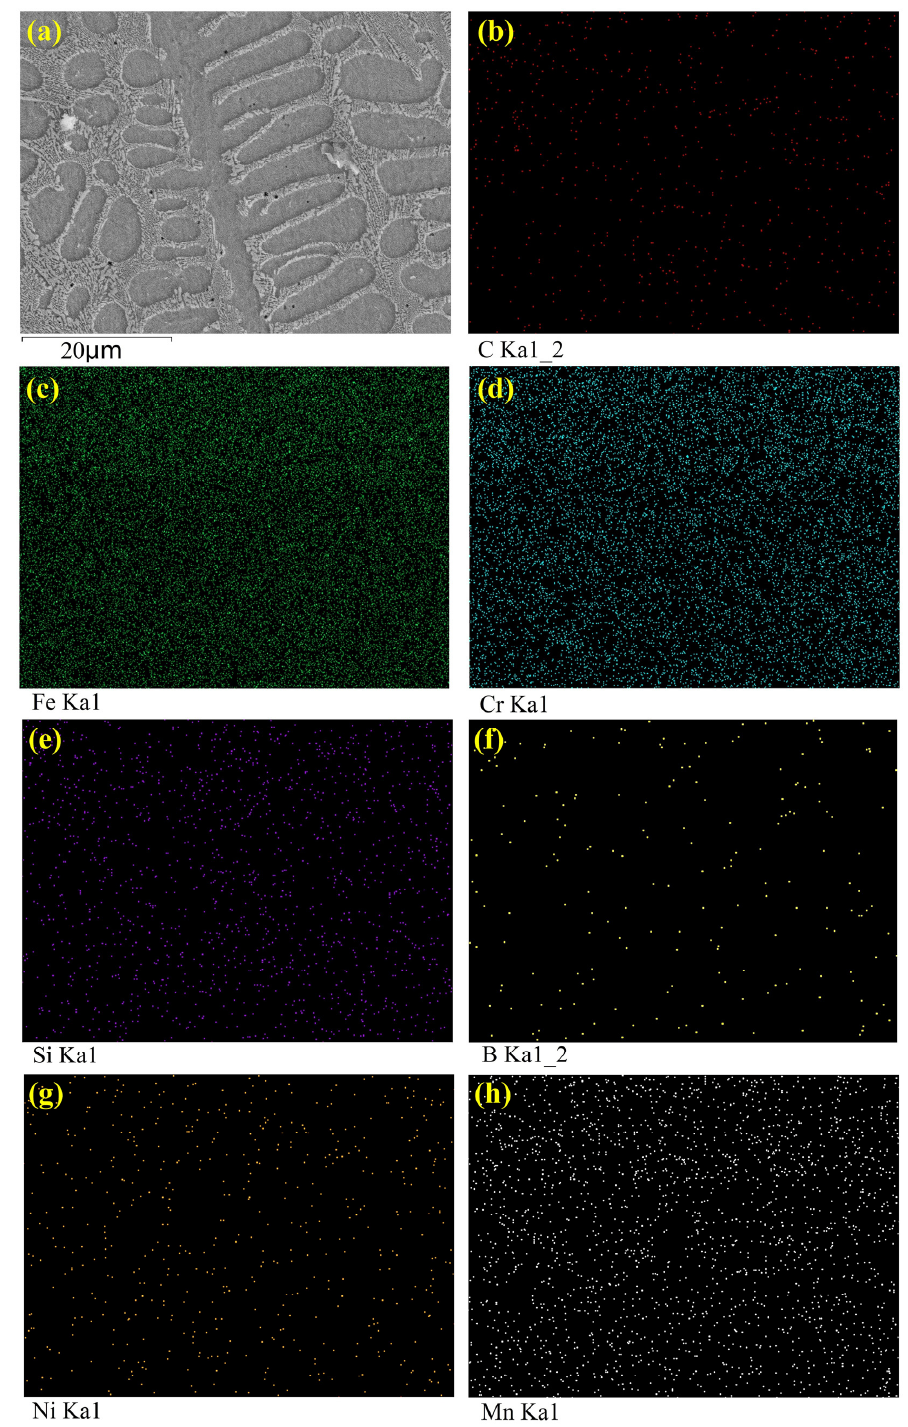
Figure 7. SEM micrograph ( a ) and the corresponding element distributions ( b – h ) of a typical dendrite structure for the coating C3.